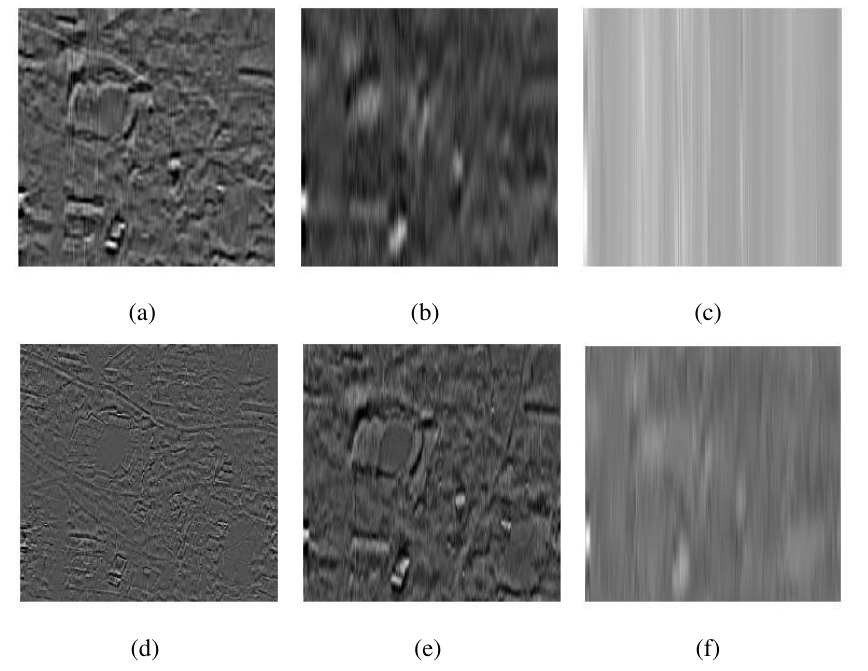
Figure 5. The IMFs obtained by applying MEMD on the I (top row) and the PAN images (bottom row), shown in Figure 3. ( a ) MEMD IMF 1 − 4